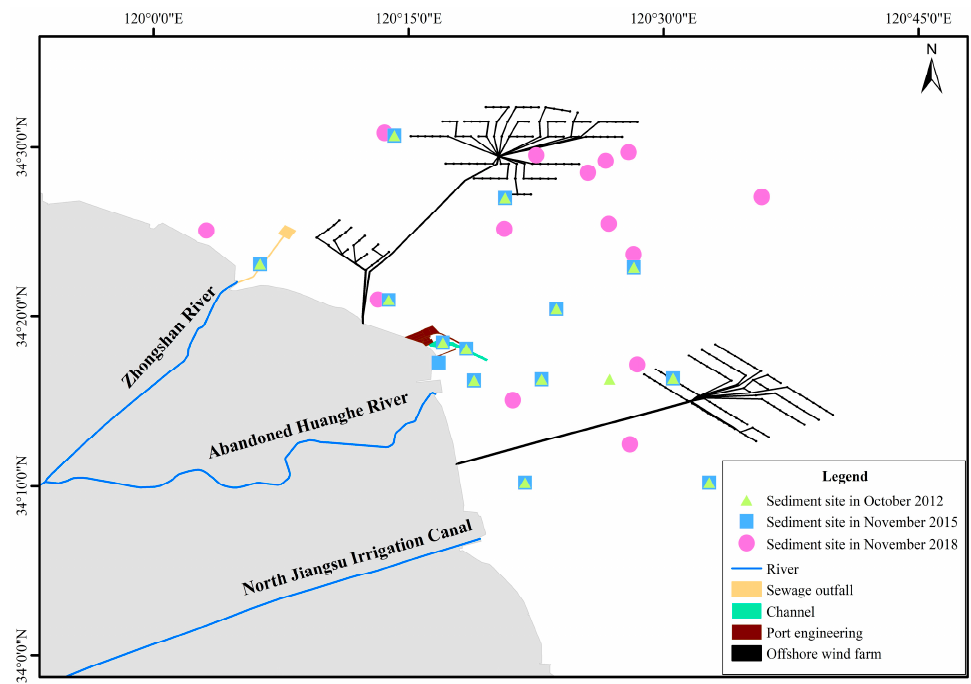
Figure 1. Location of the sample sites and development and utilization of sea areas.